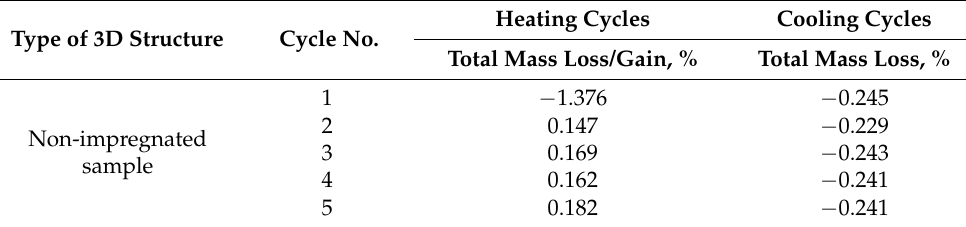
Figure 8. Thermal curves of the non-impregnated 3D ZnO-CNT structure: ( a ) TGA-DTG curves-first heating cycle. The inset shows the TG curves for 2nd–5th heating cycles; ( b ) DSC-TGA curves-first heating cycle. Table 3. Results of the thermogravimetric analysis for non-impregnated 3D ZnO-CNT structure